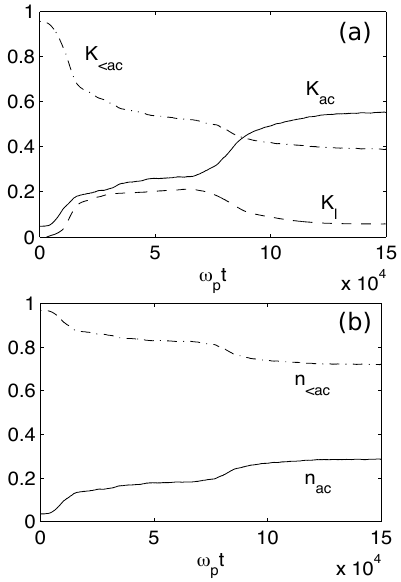
Figure 16. ( a ): Time variation of the kinetic energy density K ac of the accelerated electrons (solid line), of the kinetic energy density K < ac of the accelerated electrons with velocity v < v ac = 15.7 (dashed-dotted line), and of the absolute value of the energy density lost by the beam, K l = 1 − ( K ac + K < ac ) (dashed line). ( b ): Time variation of the corresponding electron densities n ac and n < ac . Main parameters are: n b / n 0 = 5 × 10 − 5 , v b / v T = 14 and ∆ n (cid:39) 0.01. The energies and densities are normalized by the initial beam kinetic energy and density, respectively. (Reproduced by permission of the AAS